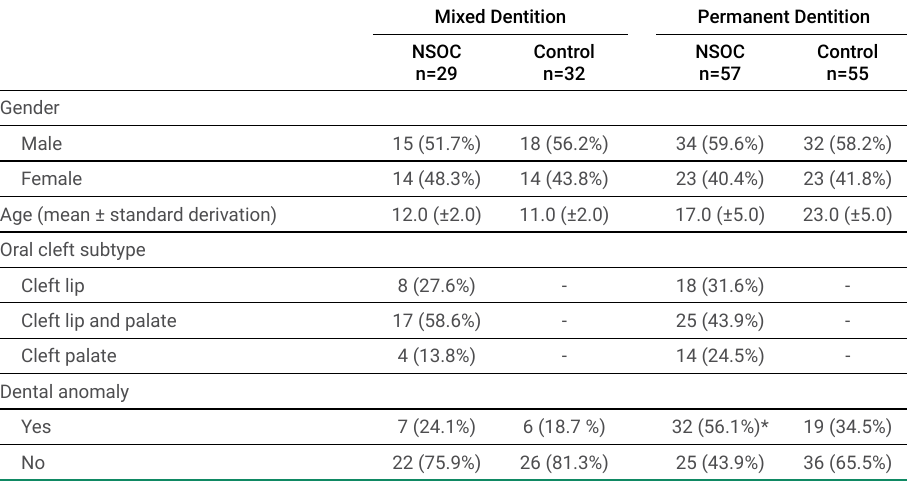
Table 1. Distribution of the groups by gender, age, clinical extent of the clefts and dental anomalies. Mixed Dentition Permanent Dentition NSOC